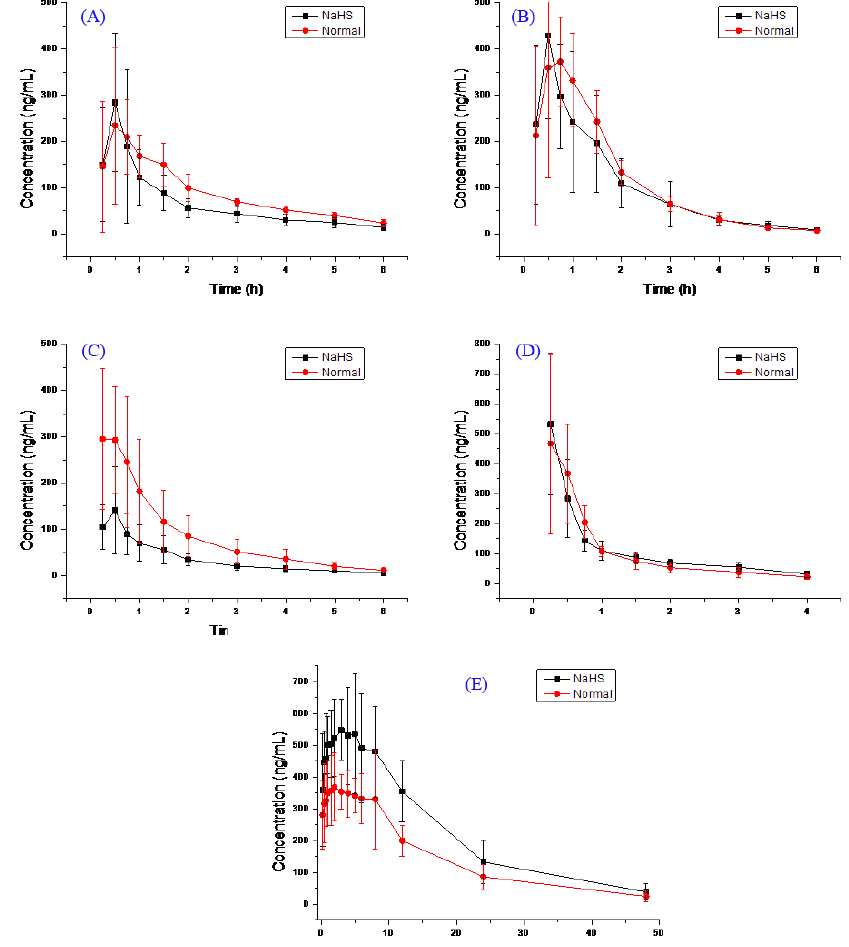
Figure 1. The pharmacokinetics profiles of bupropion ( A ); metroprolol ( B ); midazolam ( C ); omeprazole ( D ); and tolbutamide ( E